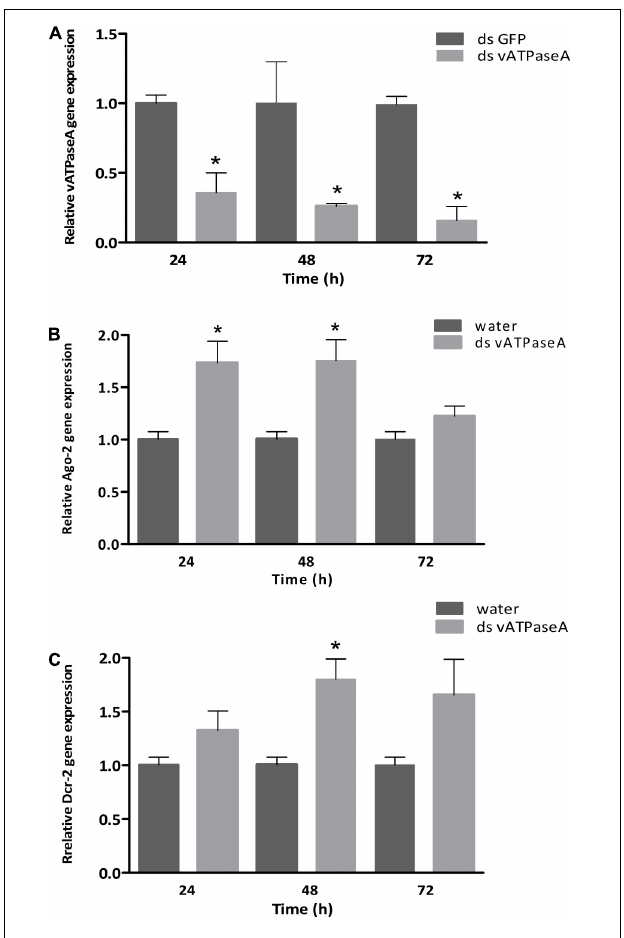
FIGURE 3 | Effect of dsRNA injection on gene expression by RT-qPCR in P. guildinii . Adults were injected with 28 ng/ µ l per mg of body weight with dsRNA targeting vATPase A or GFP used as a negative control. Adults were sampled at 24, 48, and 72 h post-injection in both treatments. As internal control, 18S and 60S genes were used. (A) vATPase A relative expression, GFP treated insects were used for normalization. (B) Ago-2 relative gene expression in dsRNA treated insects in comparison with water-treated insects. (C) Dcr-2 relative expression of insects treated with ds-vATPase A; water-treated insects were used as control. Bars represent mean and SEM based on three biological repeats consisting of a pool of three insects each. Statistical significance was calculated by an unpaired t -test. * p ≤